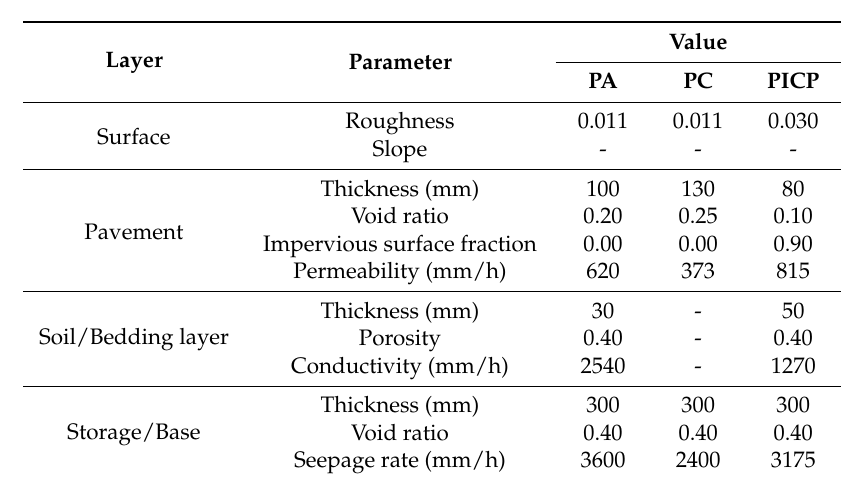
Table 2. Parameters to define for the stormwater modelling of the three major Permeable Pavement Systems (PPS): Porous Asphalt (PA), Porous Concrete (PC) and Permeable Interlocking Concrete Pavement (PICP).